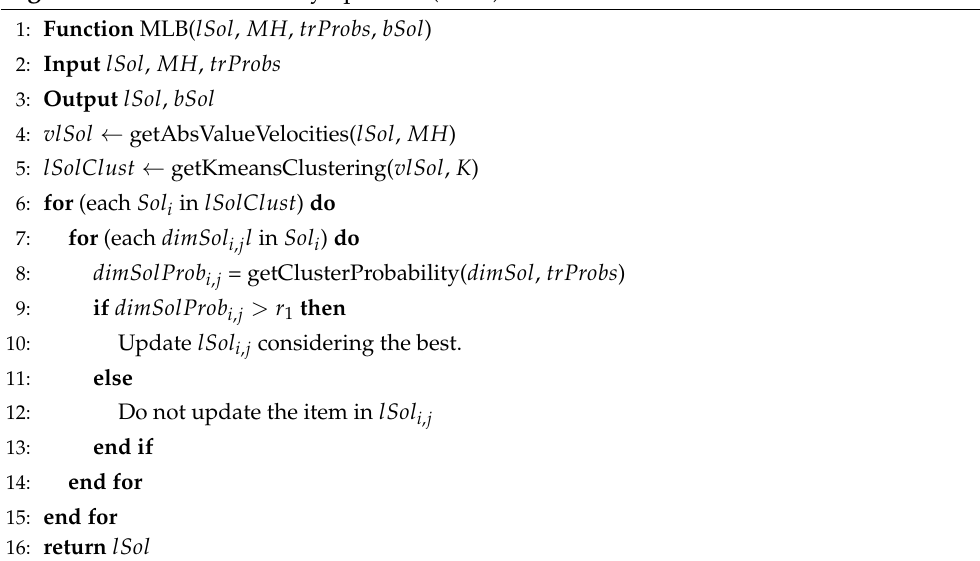
Algorithm 2 : The ML Binary operator